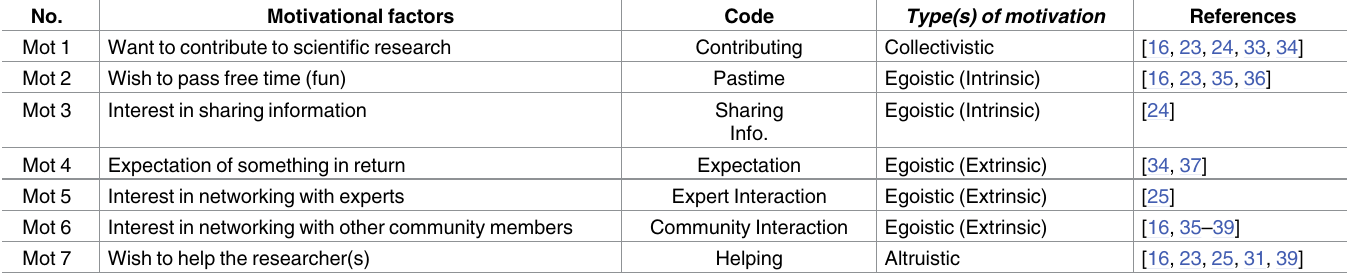
Table 1. Motivational factors identified by previous studies and used in this study. Typologyis basedon the framework of Batson et al. [31].